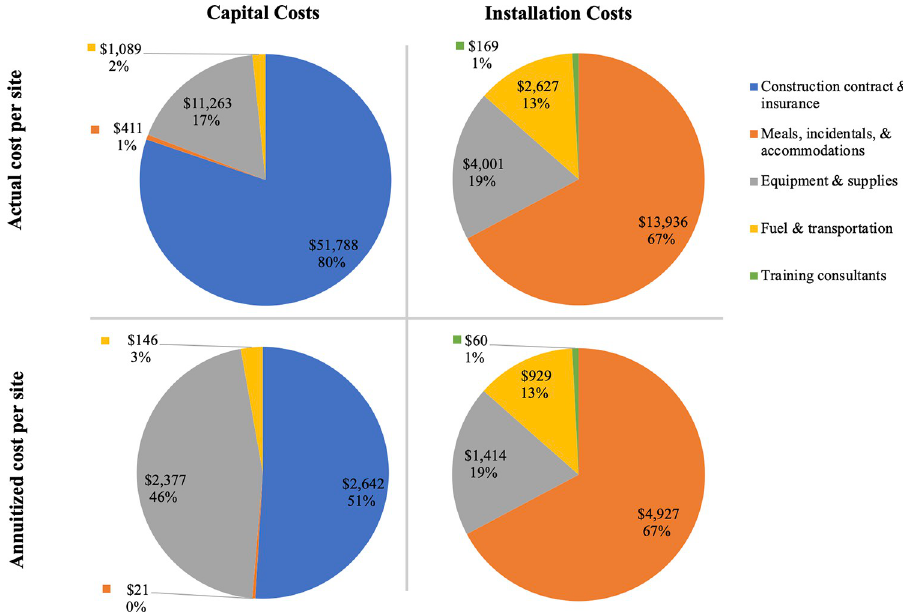
Fig 1. Per site detailed distribution of cost categories across capital and installation categories, by total actual costs and annuitized costs.